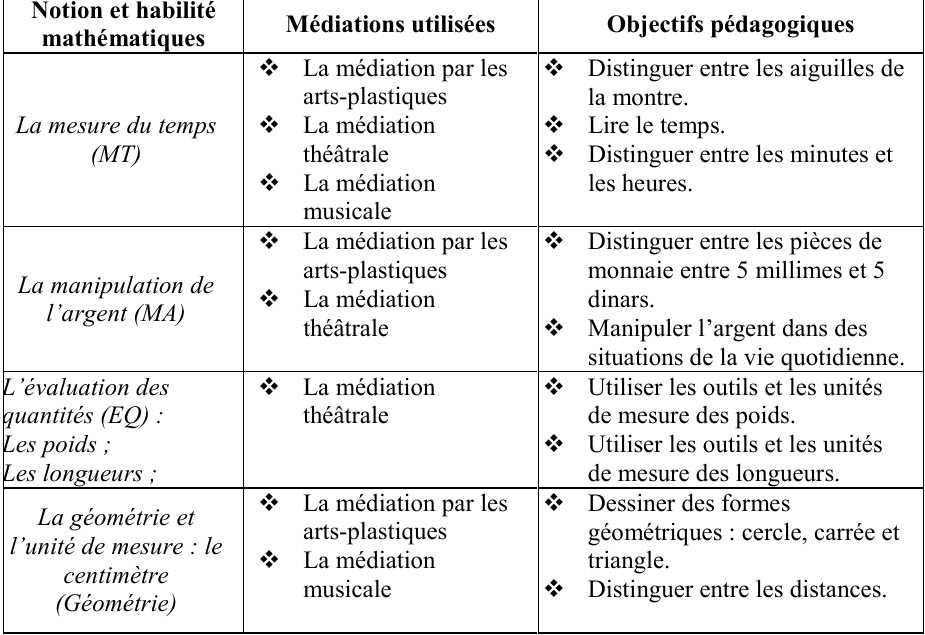
Tableau 1 : le programme d’intervention éducative Fig. 2. La consigne du test pour évaluer la notion « l’évaluation des quantités».